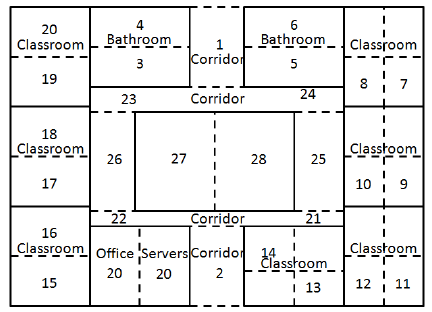
Figure 1. Distribution plan of main floor of school building used to comprise the magnetic field data